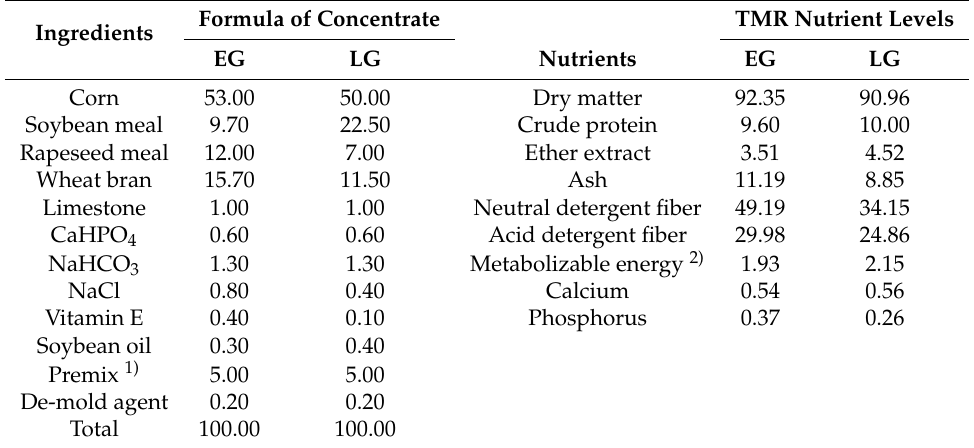
Table 1. Dietary concentrate components and nutrient levels of the basal diet (dry matter basis,